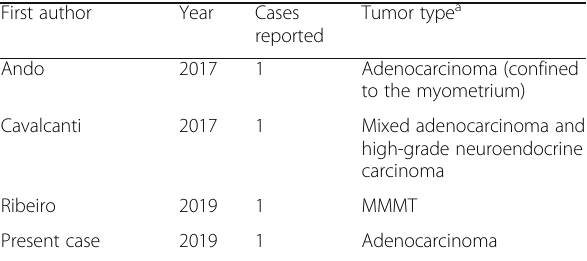
Table 1 Summary of cases of mesonephric carcinoma of the cervix and the uterine corpus reported in the literature, including the present case